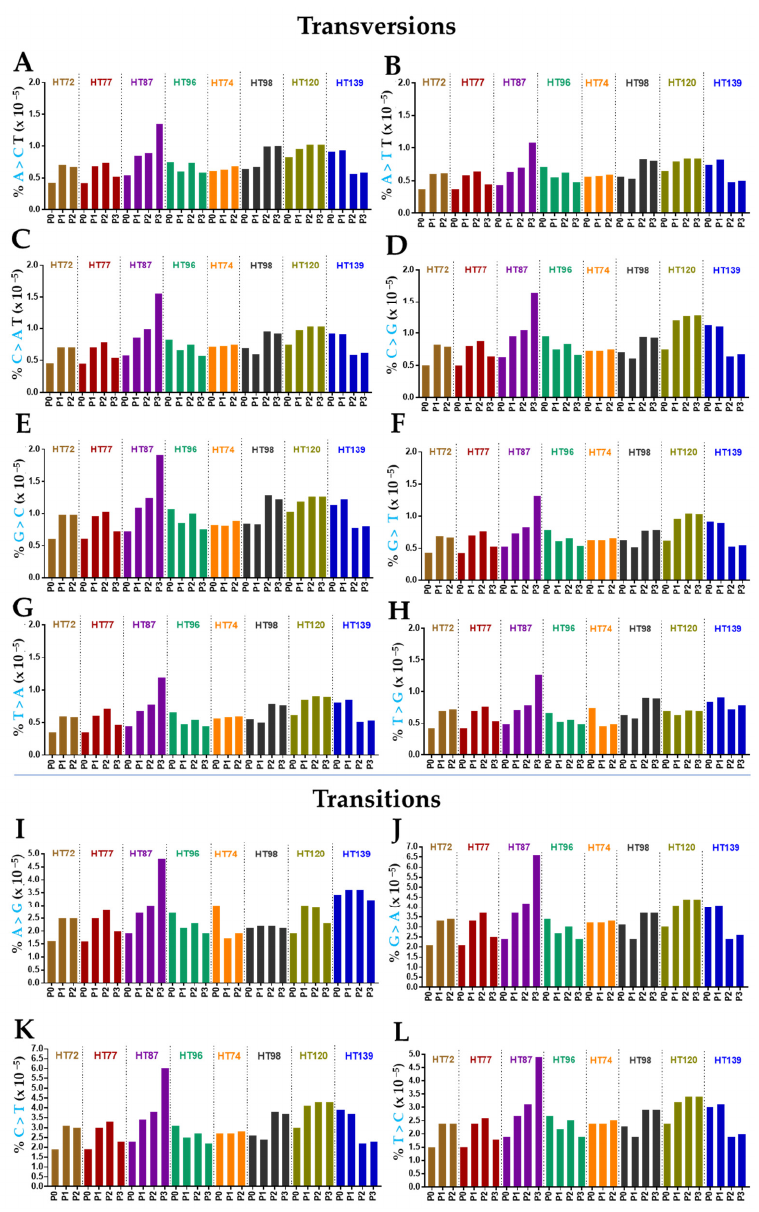
Figure 8. Percentage of transversion and transition events in all genes among P0 and their corre- sponding PDXs. Transversion events: ( A ) A > C, ( B ) A > T, ( C ) C > A, ( D ) C > G, ( E ) G > C, ( F ) G > T, ( G ) T > A, and ( H ) T > G. Transition events: ( I ) A > G, ( J ) G > A, ( K ) C > T, ( L ) T > C. The data is normalized to total mappable variant counts specific to that particular sample. These data were normalized against sequencing depth.